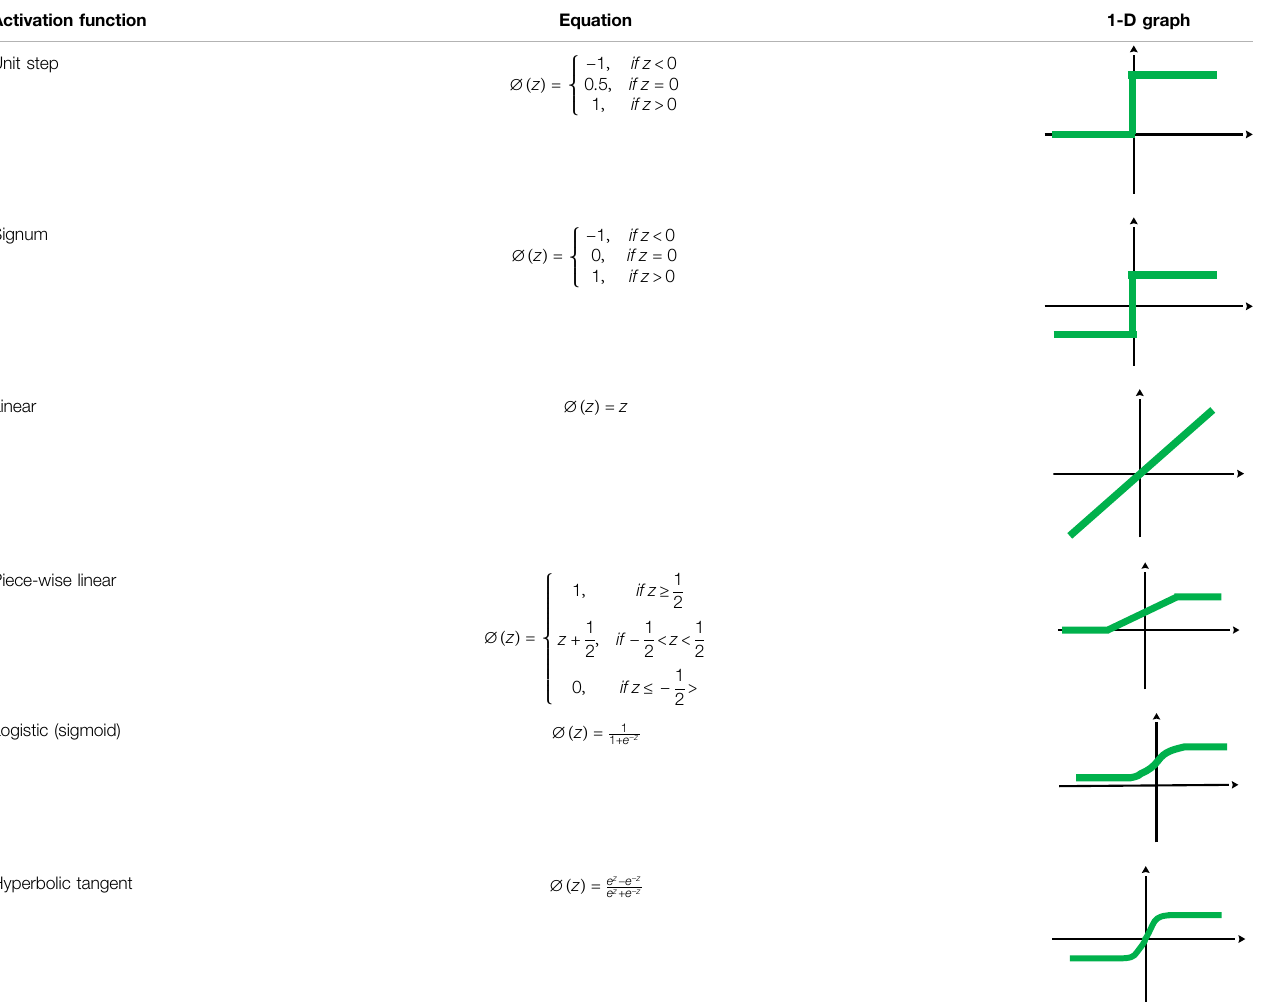
TABLE 11 | Activation functions for the arti fi cial neural